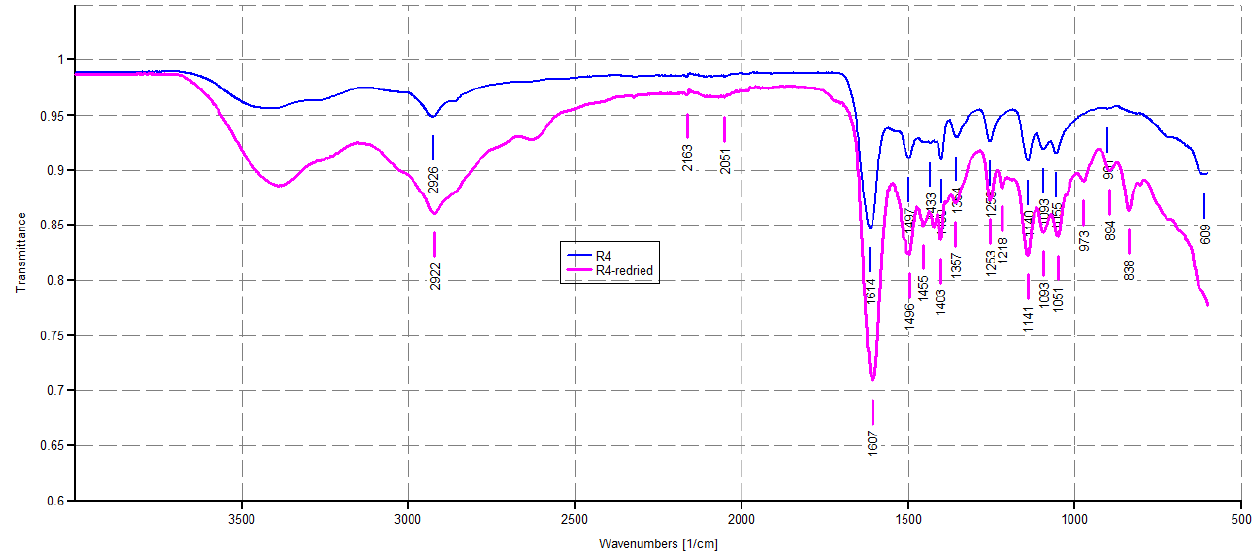
Figure 3. ATR-FTIR spectra of R4 as obtained by polymerization (blue line) and R4 achieved after drying a sample of R4 swollen at its maximum swelling capability (pink line).